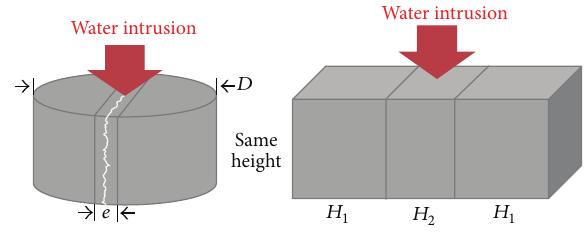
Figure 3: REV for actual water